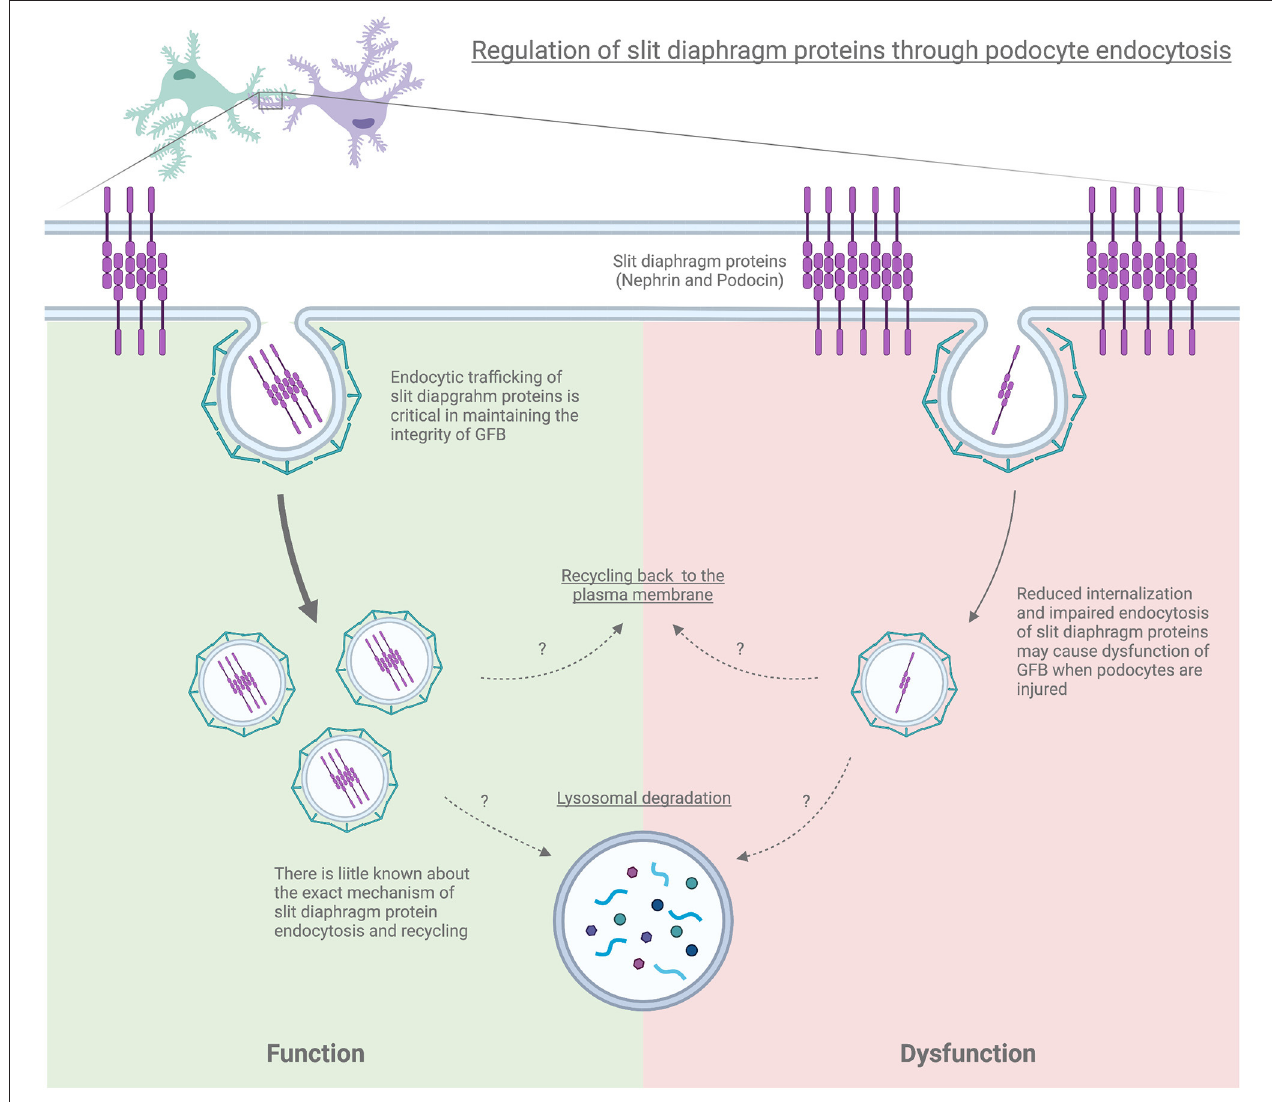
FIGURE 2 | Regulation of slit diaphragm proteins through podocyte endocytosis.